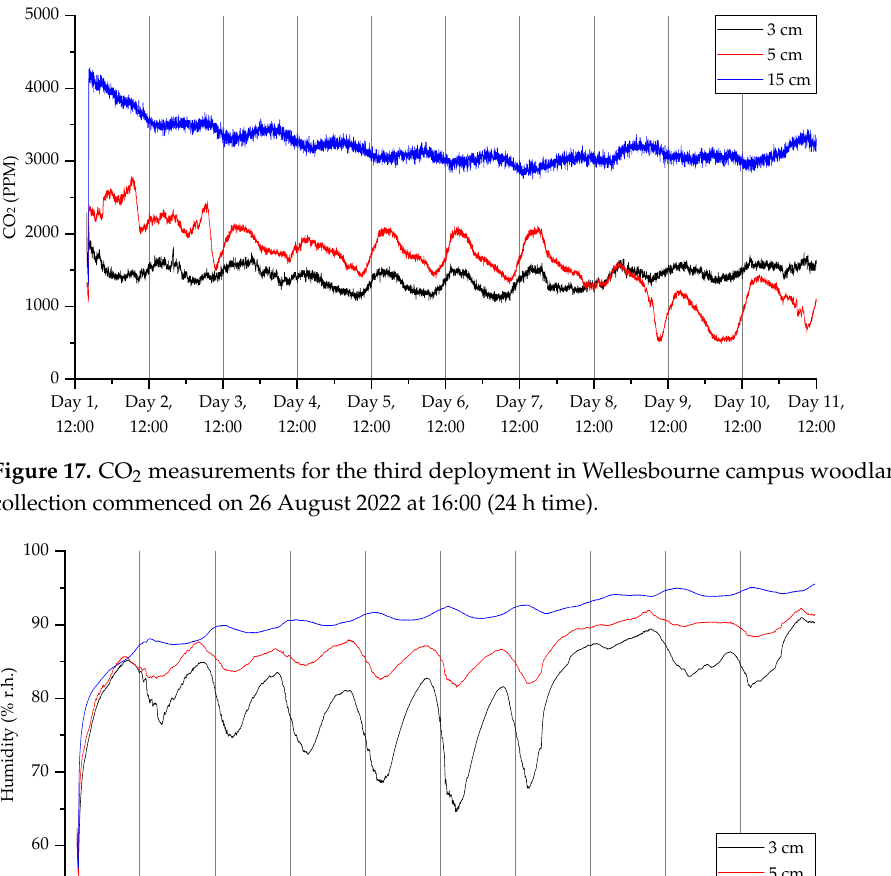
Figure 20. VOC measurements for the third deployment in Wellesbourne campus woodland. Data collection commenced on 26 August 2022 at 16:00 (24 h time). The use of commercial CO 2 probes in soils research is best highlighted by the Na ‐ tional Ecological Observatory Network (NEON) throughout North America. In conjunc ‐ tion with other environmental measurements, Vaisala GMP ‐ 343 NDIR CO 2 probes have been placed at various soil depths from 0 to 20 cm, replicated across 46 sites in continental USA, Hawaii, and Puerto Rico. To assess our probes against a commercial system, we compared publicly available soil CO 2 data from three eastern USA NEON sites, with sim ‐ ilar vegetation to the Wellesbourne woodland, against our concentrations from deploy ‐ ment three. NEON data was taken from the same time period (26 September–6 October 2022) [47]. We can see that when all CO 2 concentration datapoints from within this timeframe are plotted as a function of soil depth, there is a clear trend of increasing CO 2 concentration with depth (Figure 21). This is regardless of probe type, illustrating that our system compares well with commercial systems. Further, it could be argued that our sys ‐ tem exceeds the capacity of the Vaisala GMP ‐ 343 by being completely wireless.